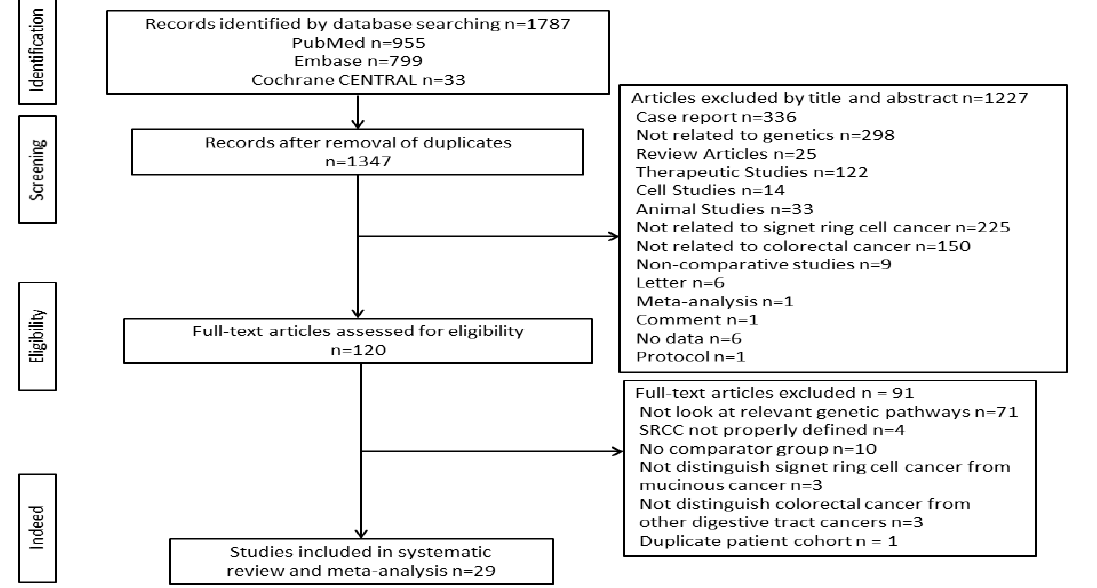
Figure 1. Flowchart for selection of eligible articles. Table 1. Characteristics of included